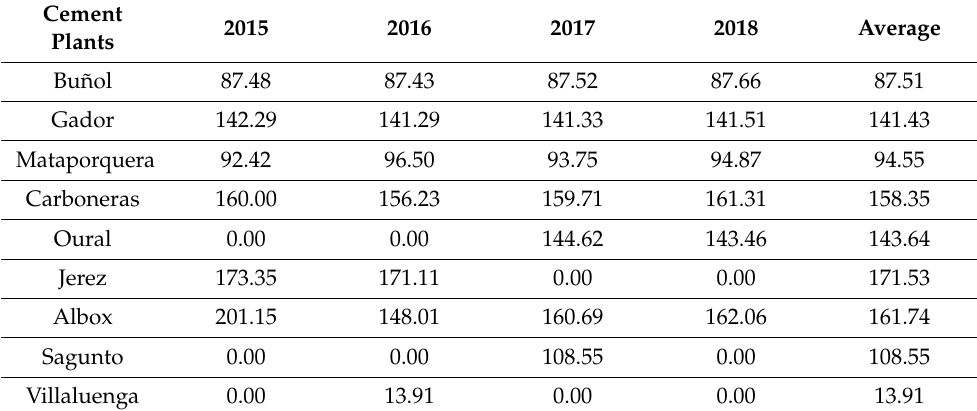
Table 8. Energy consumed to transport the fuel produced to each cement plant ( E transport · 2 ); (kWh/t waste ).